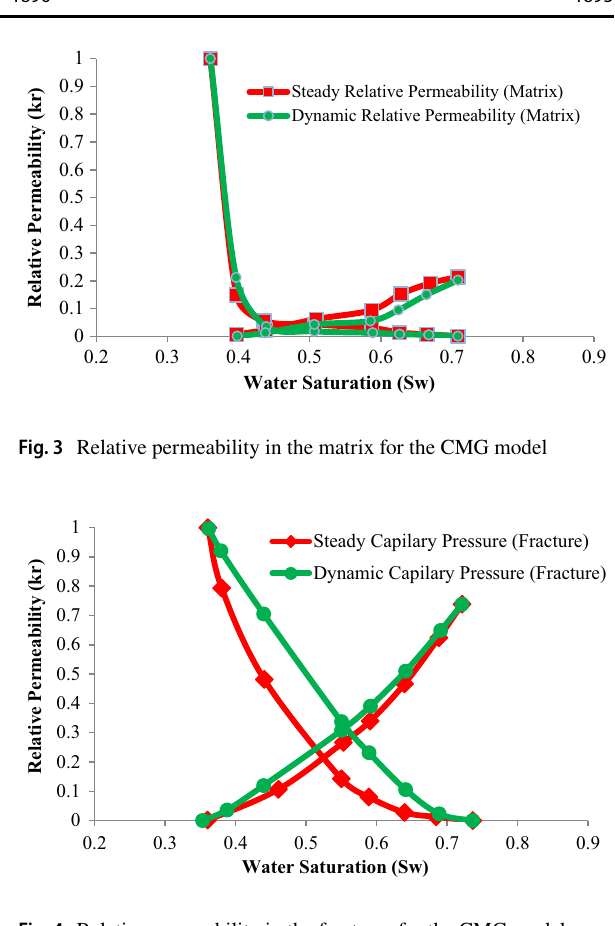
Fig. 4 Relative permeability in the fractures for the CMG